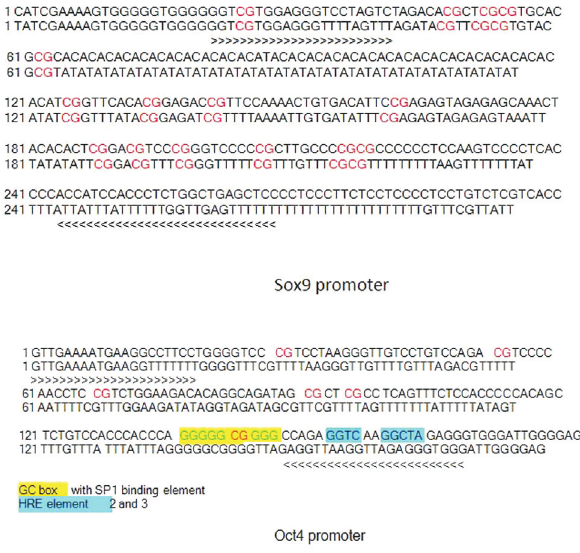
Figure 1 - The complete bisulfite converted nucleotide sequence of the 5’UTR of Sox9 and Oct4 genes. The 250 bp region in the 5’UTR of Sox9 (harboring 15 CpG sites) and 145 bp regions in the promoter of Oct4 (har- boring 06 CpG sites) were analyzed for their methylation pattern. CpG sites are highlighted in red. The locations of transcription factor binding sites are shown in different colors (yellow and blue) in Oct4